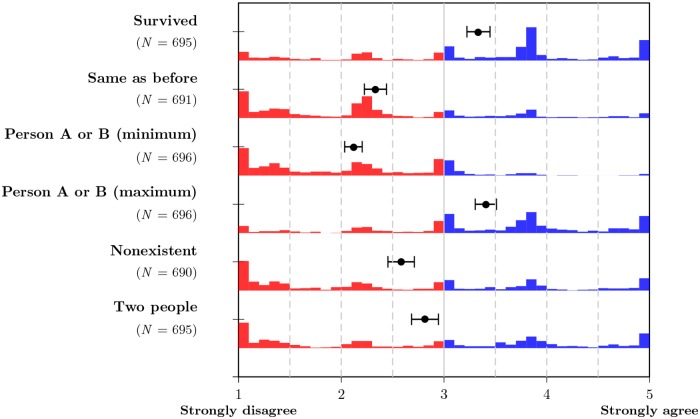
Histogram and means of responses to post-questionnaire items.Blue bars indicate a tendency to agree with the statement; red bars, to disagree. For the two questions regarding being person A or person B (whose composition differs between conditions), the smaller and the larger value for each participant were pooled and analyzed as minimum and maximum value. Dots represent means; whiskers denote 99% confidence intervals around the means.